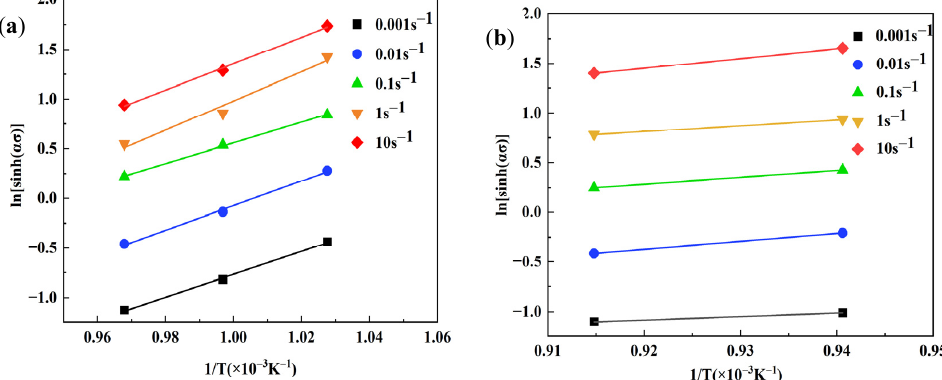
Figure 5. Curves of ln[sinh( ασ )] − 1/ T at different phase fields: ( a ) α + β and ( b ) β .